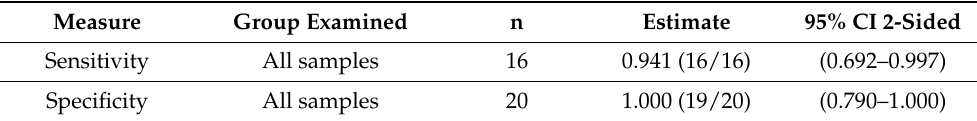
Table 2. AKRO-QC-ICG imaging Pluronic F-127 hydro-gel#30 detects the human breast cancer tissue in vivo with a high sensitivity and specificity in NSG PDX mouse